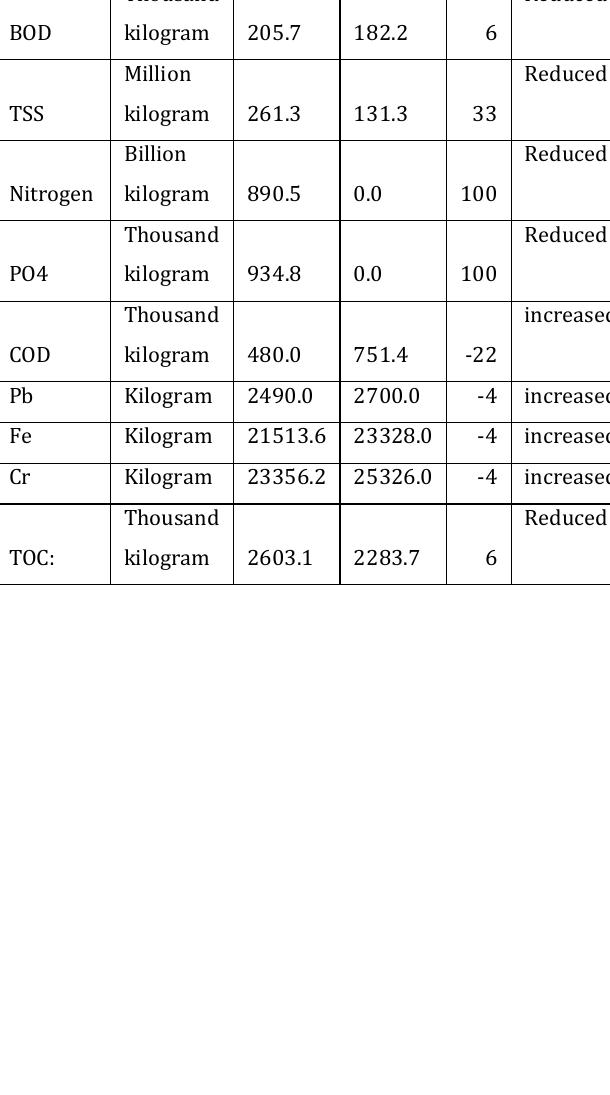
Table (2) Pollutant Load from Soba WWTP to white Nile (WWTP): Waste water treatment plant